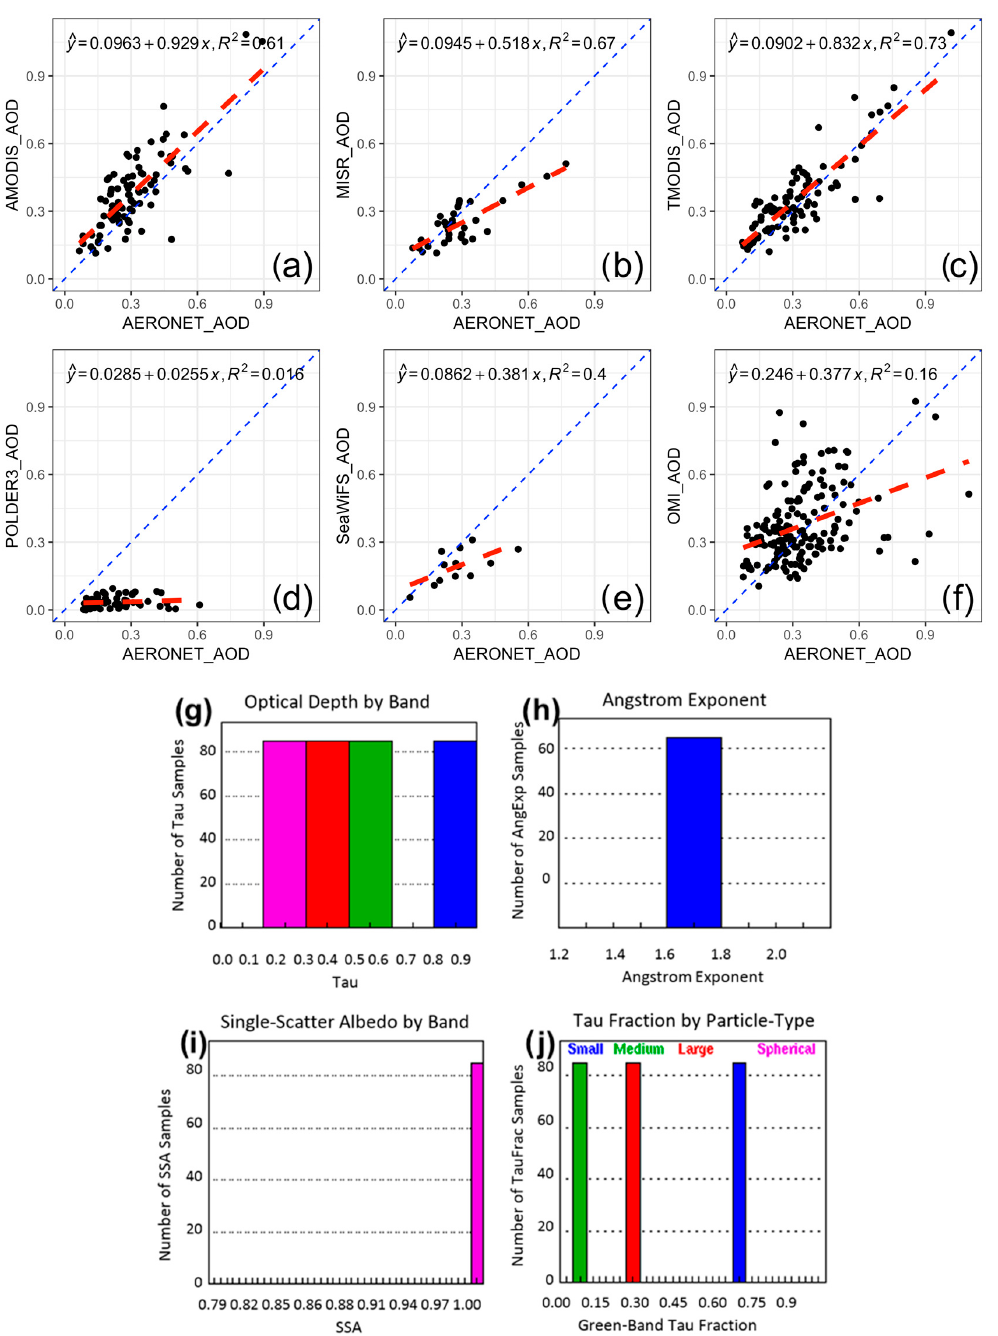
Figure 2. Scatter plots of Cairo AErosol RObotic NETwork (AERONET) aerosol optical depth (AOD) observations as to AOD data from ( a ) Aqua MODIS, ( b ) MISR, ( c ) Terra MODIS, ( d ) POLDER3, ( e ) SeaWiFS, and ( f ) OMI in EMA and Cairo University stations. Aerosol histograms with no cloud contamination where color indicates band for ( g ) optical depth, ( h ) Ångström exponent, ( i ) single scattering albedo (SSA), and ( j ) Tau (AOD) fraction by particle over Egypt on 14 September 2008.